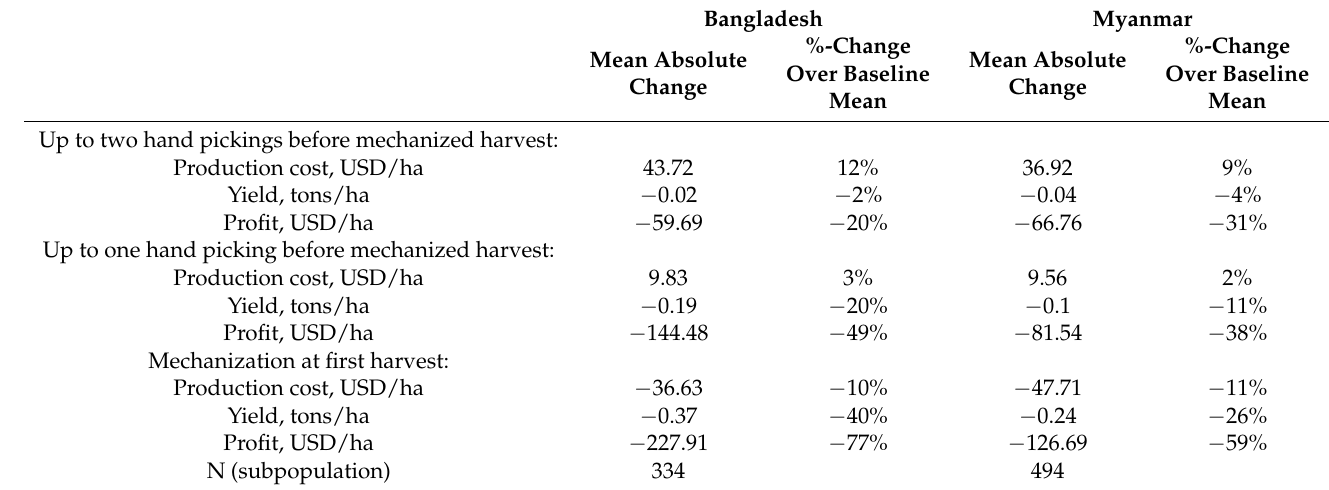
Table 5. Estimated effects of mechanization at the farm